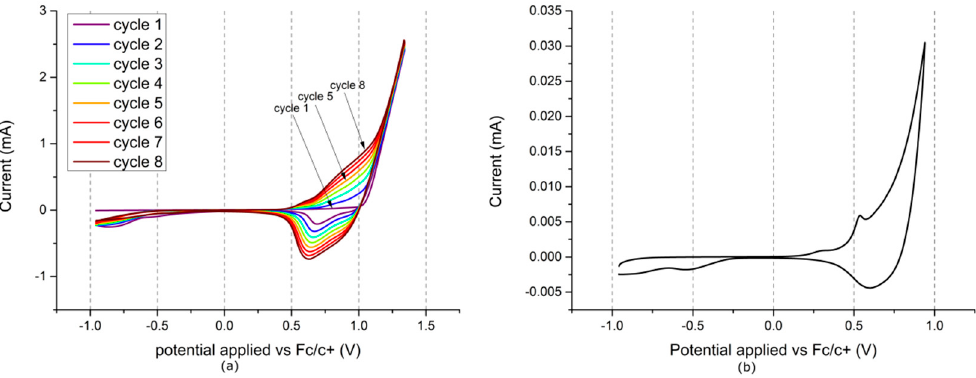
Figure 5. Electrochemical polymerisation of fluorene ( a ), CV of the deposited layer ( b ).